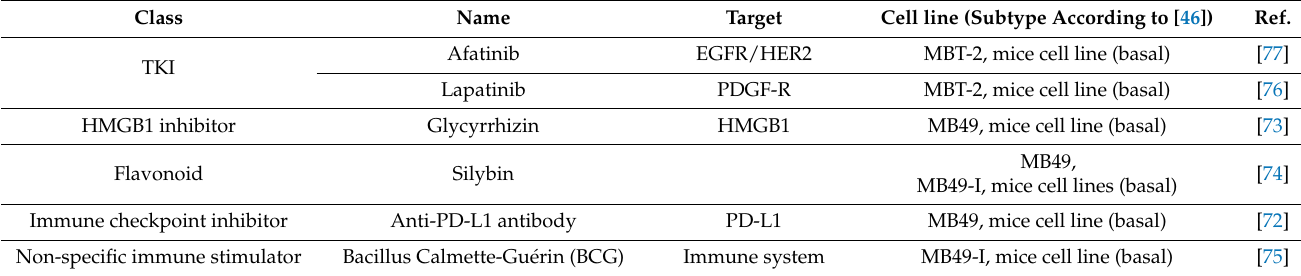
Table 8. Targeted agents used as radiosensitisers in preclinical studies using syngeneic